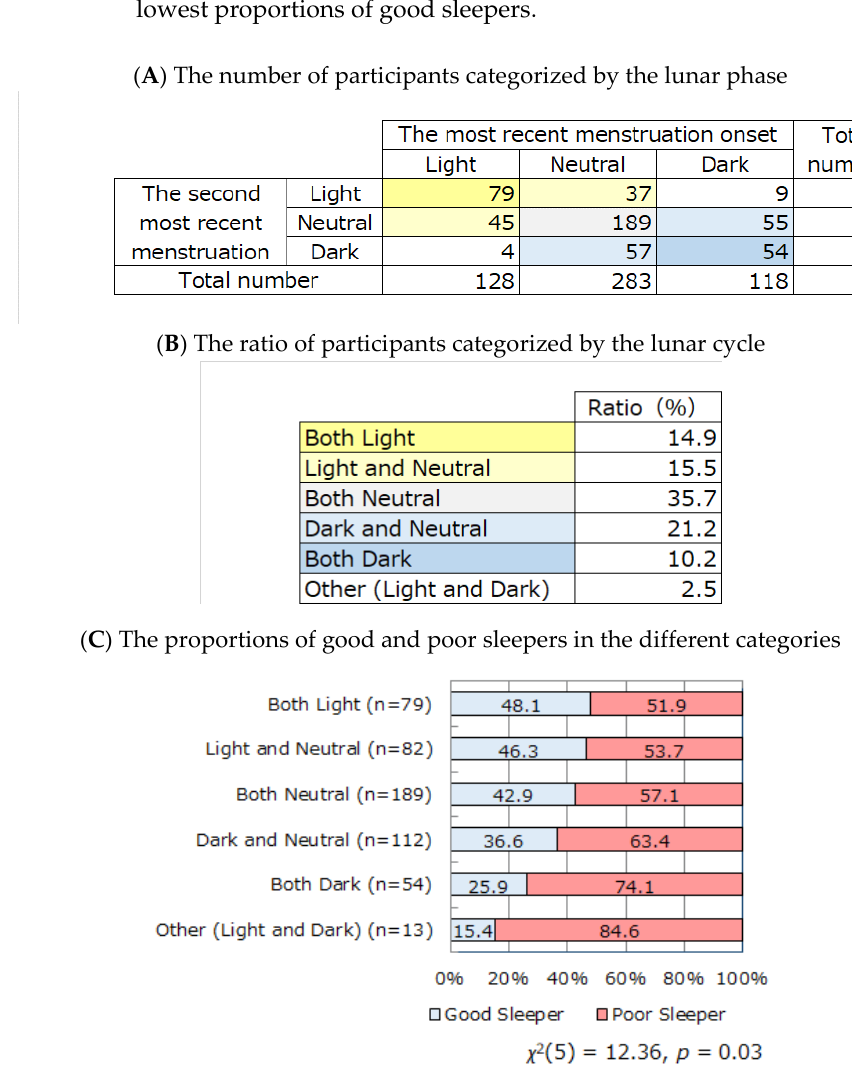
Figure 4. The relationship between subjective sleep quality and the combination of lunar phase (light, dark, neutral periods) in the two most recent menstruation onsets. Participants were categorized by the combination of lunar phases at the most recent and the second most recent onset of menstrual cycle ( A , B ), and the proportions of good and poor sleepers were calculated ( C ). The proportion of good sleepers was highest in the “both light period” group, followed by the “light and neutral period” group and the “both neutral period” group. The “both dark period” group and the “other (light and dark period)” group showed the lowest proportions of good sleepers.